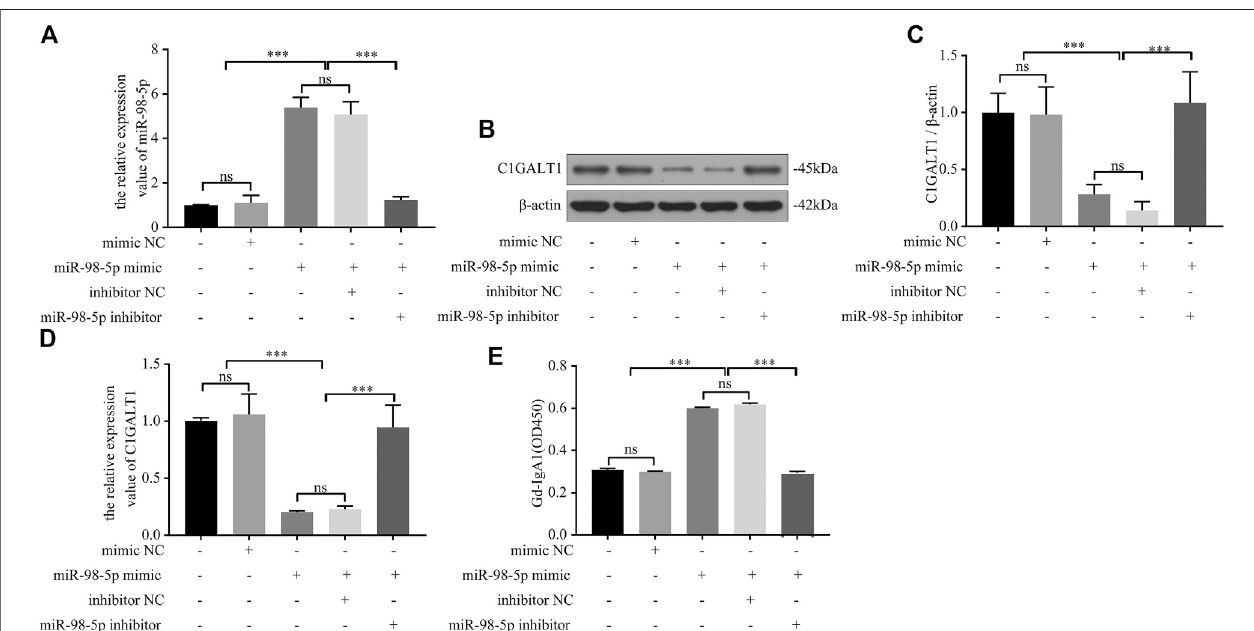
FIGURE3| miR-98-5pregulatedtheexpressionofC1GALT1andGd-IgA1levelsinDAKIKIcells. (A) TheexpressionlevelofmiR-98-5pwasanalyzedbyqRT-PCR in DAKIKI cells. The relative expression level of miR-98-5p in the blank, mimic NC, miR-98-5p mimic, miR-98-5p mimic + inhibitor NC, and miR-98-5p mimic + miR-98- 5pinhibitorgroupswere1.00 ± 0.01,1.11 ± 0.27,5.39 ± 0.38,5.07 ± 0.50and1.22 ± 0.13. (B) TheexpressionofC1GALT1proteinwasanalyzedbywesternblottingin DAKIKI cells. (C) Fold changes were calculated by determining the ratios of C1GALT1/ β -actin band intensities in DAKIKI cells. The semiquantitative relative level of C1GALT1 protein in the blank, mimic NC, miR-98-5p mimic, miR-98-5p mimic + inhibitor NC, and miR-98-5p mimic + miR-98-5p inhibitor groups were 1.00 ± 0.14, 0.98 ± 0.20, 0.28 ± 0.07, 014 ± 0.06and 1.08 ± 0.22. (D) The expression levelsofC1GALT1mRNA wereanalyzed byqRT-PCRinDAKIKI cells. Therelative expression levels of C1GALT1 mRNA in the blank, mimic NC, miR-98-5p mimic, miR-98-5p mimic + inhibitor NC, and miR-98-5p mimic + miR-98-5p inhibitor groups were 1.00